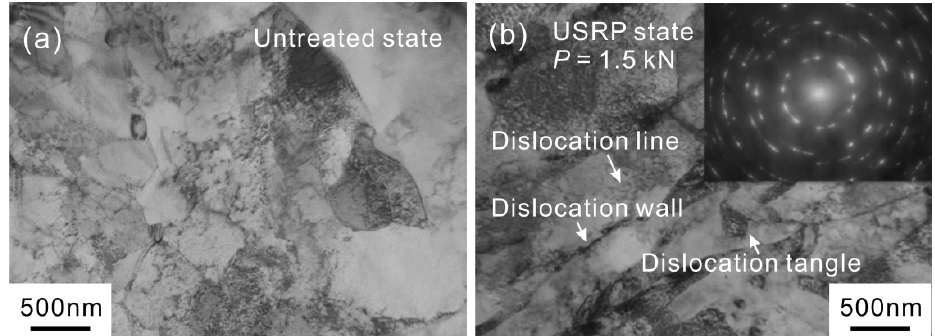
Figure 7. Transmission electron microscope (TEM) micrographs of ( a ) the untreated specimen and ( b ) USRP specimen with a static load of 1.5 kN at a depth of ~100 μm from the surface. The corresponding selected area electron diffraction (SAED) pattern was obtained from the USRP specimen.